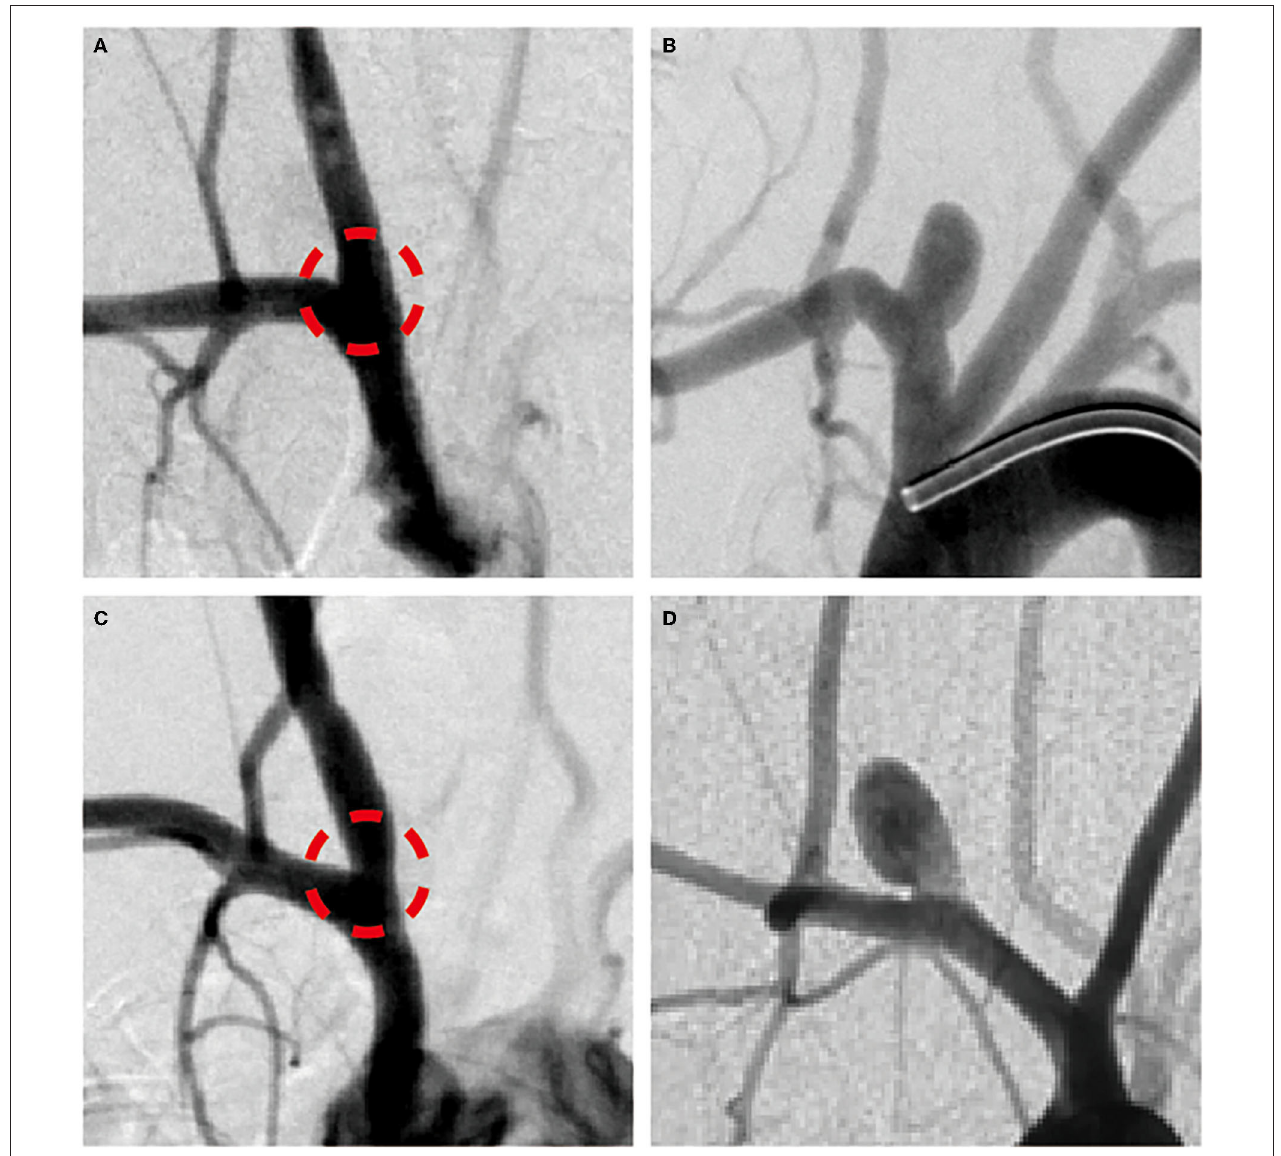
FIGURE 3 | (A,C) The angiogram immediately after right common carotid artery (RCCA) incubated by elastase and (B,D) 3-week follow-up angiogram to confirm the creation of RCCA aneurysm model in rabbits of groups 1 and 2,